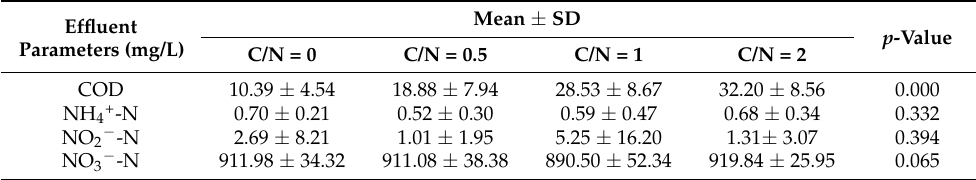
Table 2. Mean, standard deviation (SD), and variance analysis of effluent parameters under different C/N ratios. The abnormal data caused by the failure of the aeration system on the 16th and 76th days were excluded.